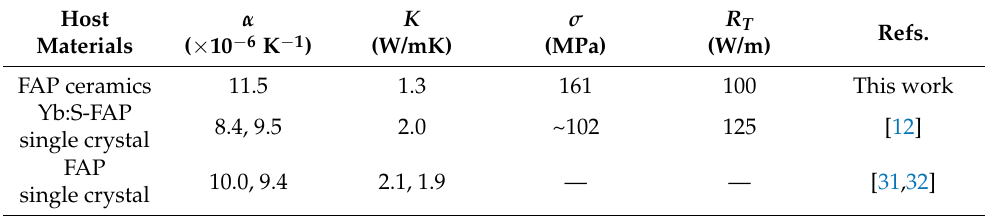
Table 2. Physical properties of the FAP ceramics sintered at 1000 ◦ C along with thermal shock parameter together with FAP and S-FAP single